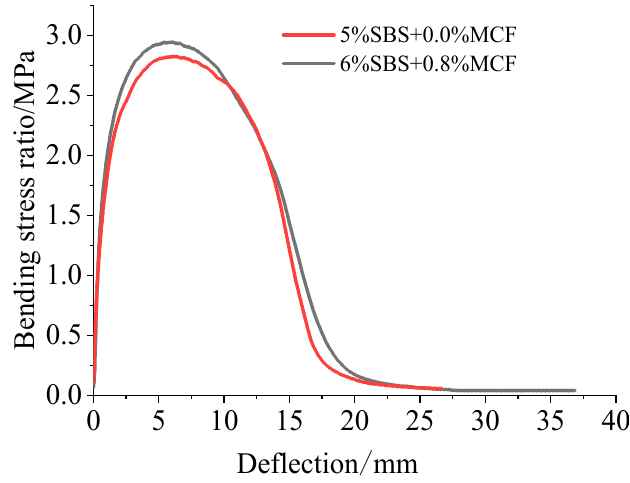
Figure 7. Bending stress–deflection curve.